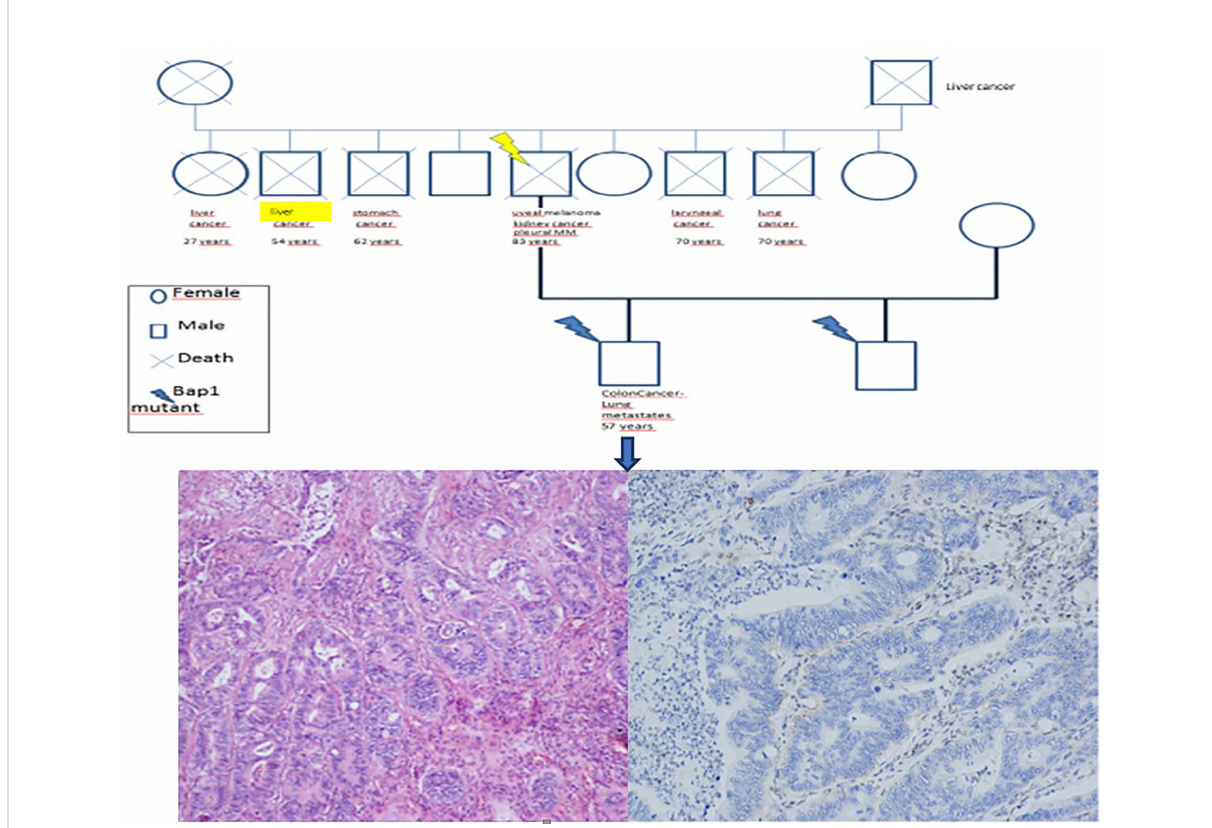
FIGURE 1 Histological review of the uveal melanoma ( A , haematoxylin and eosin staining, 100x original magni fi cation) and renal carcinoma ( C , haematoxylin and eosin staining, 100x original magni fi cation). In both tumours, BAP1 was negative by immunohistochemistry ( B, D , immunohistochemistry,